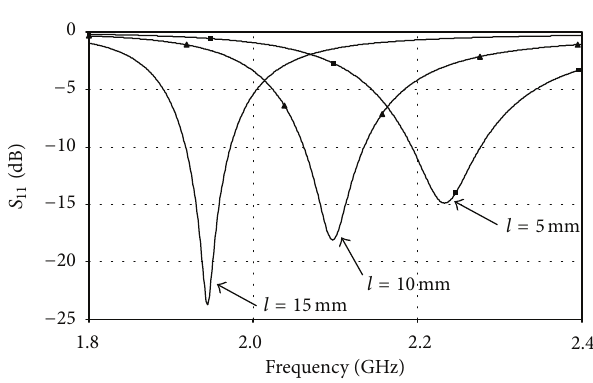
Figure 5: 𝑆 11 parameter of the IFA structure for different stub lengths.